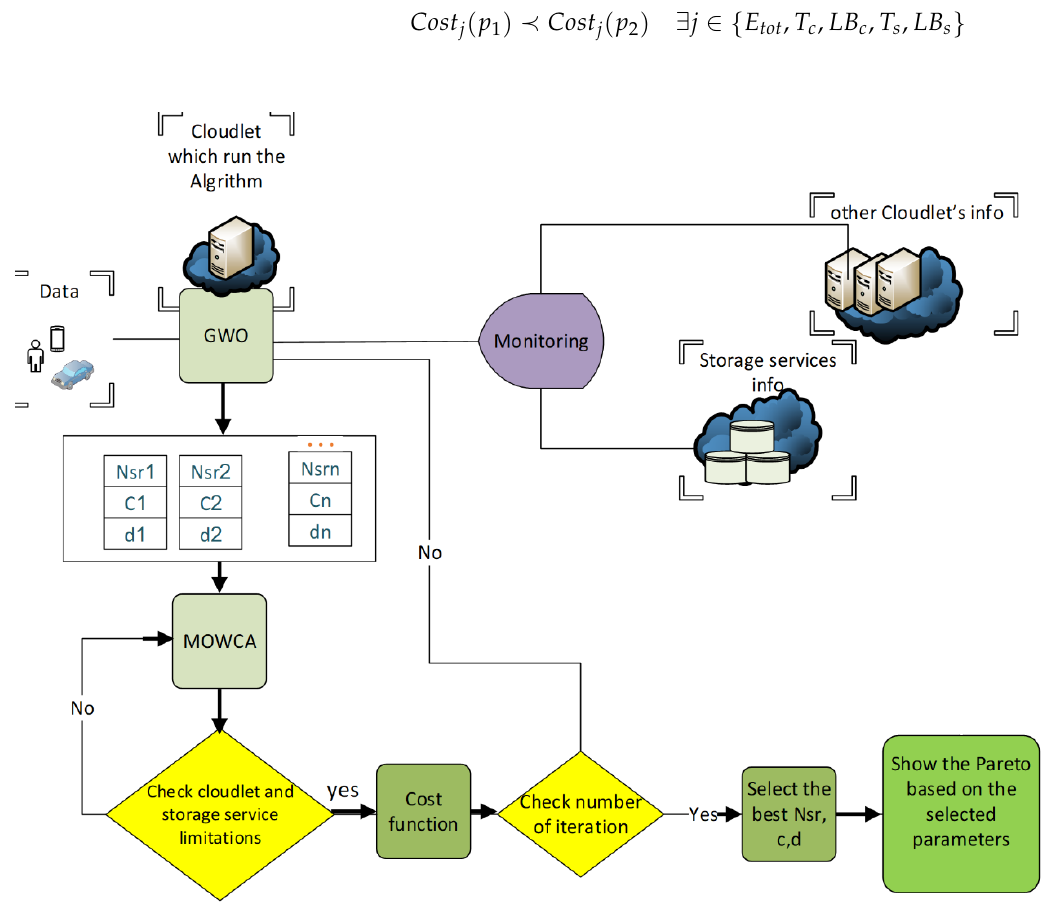
Figure 2. Decision-making block diagram.